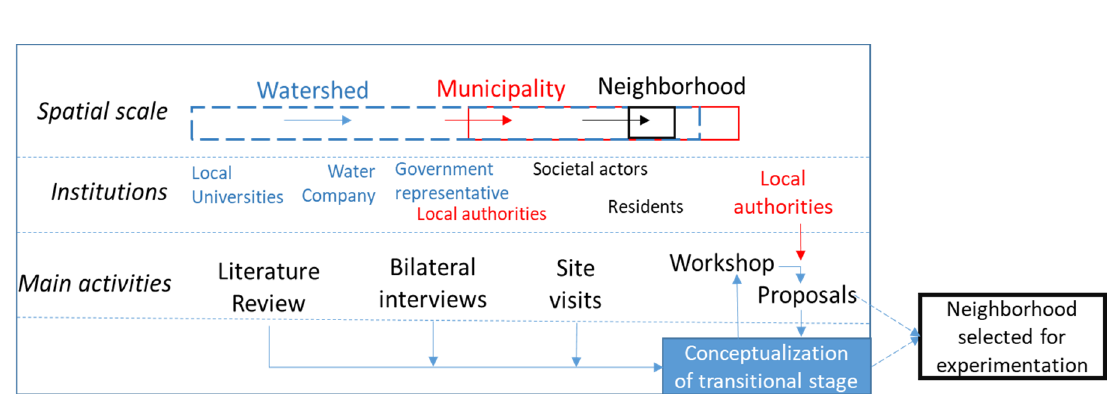
Figure 2. The methodology employed to conceptualize the existing urban water stage in the case of study considering actors at the watershed (blue), municipal (red), and neighborhood scale (black).